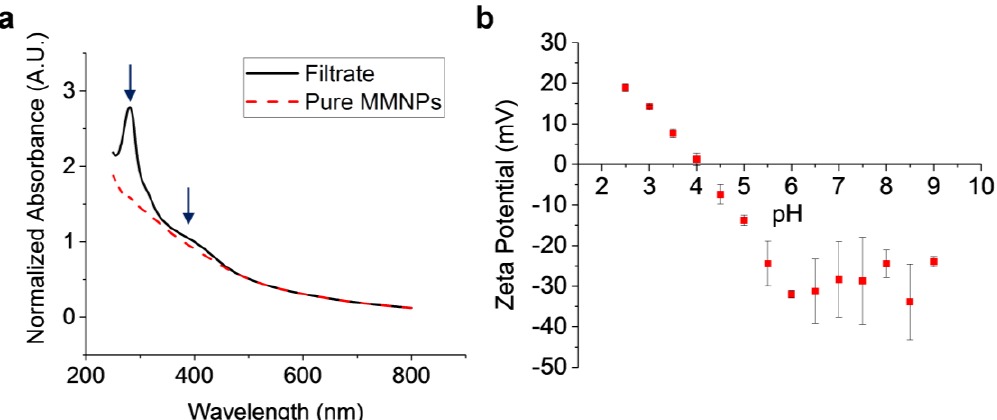
Figure 1. Ultraviolet–visible (UV–Vis) absorbance and surface charge of polydopamine-based melanin-mimetic nanoparticles (MMNPs). ( a ) UV-Vis spectra of purified MMNPs and filtrate removed from crude product via 10 kDa centrifugal filtration. Arrows in ( a ) indicate the two peaks observed at 280 and 398 nm in the filtrate absorbance spectrum that are absent in the purified MMNP absorbance spectrum. A.U.: Arbitrary units. ( b ) Zeta potential of MMNPs at pH 2.5–9.0. The isoelectric point is approximately pH 4.0 – 4.1.